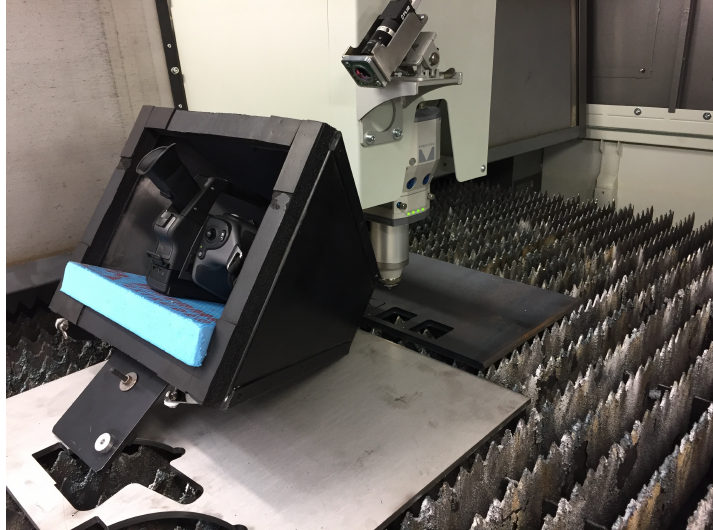
Figure 2. The IR camera FLIR SC660 looking at the cutting process. It is protected by a metallic shield and it looks at the cutting zone through a PK7 windows to protect from the molten steel gushing from the cutting point especially during periodic pulsed mode.